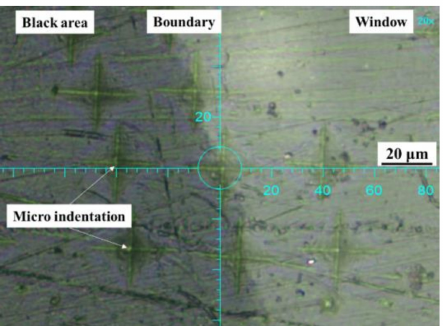
Figure 5. Micro-indentations on black compound, window, and along the boundary.